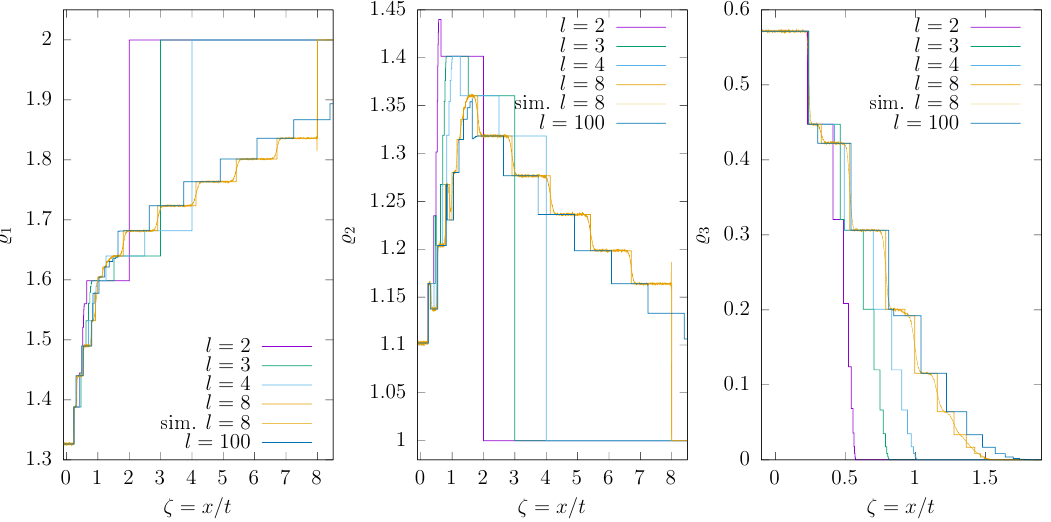
Figure 7: Ball densities (cid:37) i =1 , 2 , 3 obtained from GHD calculations and plotted as a function of ζ . The different colors correspond to different values of the parameter l (1) in T . The initial state is defined by the fugacities z 1 ,L = 1 z 2 ,L = 0 . 7 , z 3 ,L = 0 . 3 l and with the vacuum state in the right part. For l = 8 the results of simulations (at t = 1000 and N = 3 . 10 5 ) are also shown. The sum of the three densities is samples equal to 3 by construction (notice the different vertical scales in the different panels).